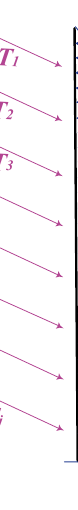
Figure 2. Sketch map of earth